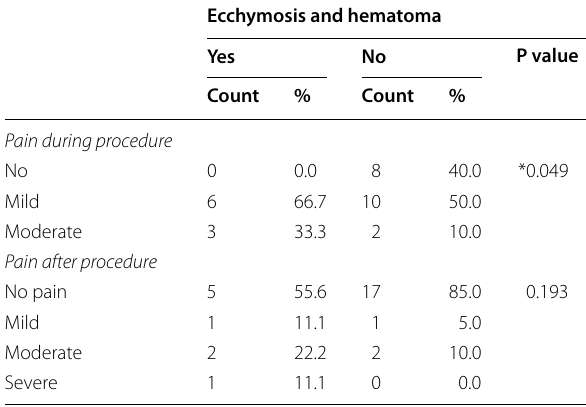
The correlation between hematoma development was clinically significantly related to occurrence of pain intra-procedural, although there was not significant difference between hematoma and post-procedural pain, which may be attributed to that most hematomas were small in size and we allowed our patients to take post-procedural mild analgesics as paracetamol